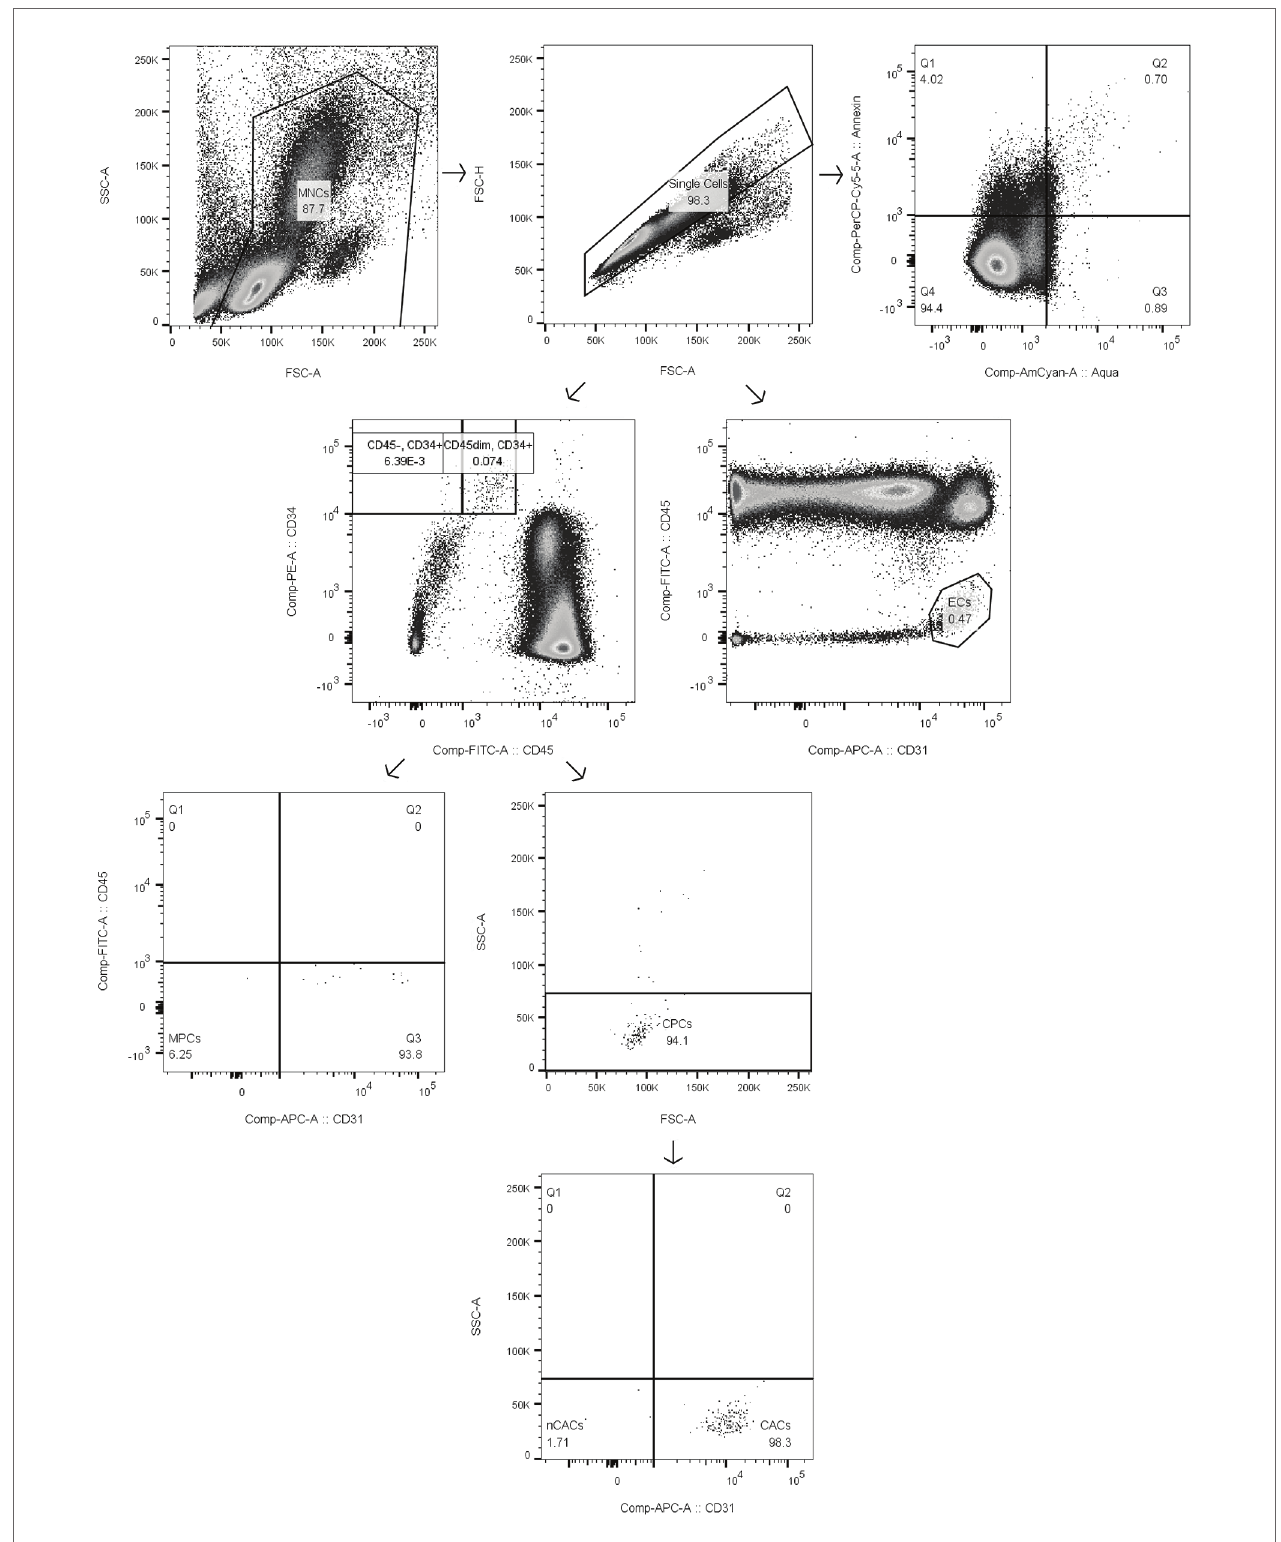
FIGURE 1 | Gating strategy of mononuclear cells (MNCs), circulating angiogenic precursor cells (CACs), circulating non-angiogenic precursor cells (nCACs), mesenchymal precursor cells (MPCs), endothelial cells (ECs), and apoptotic MNCs as representative example of gating of apoptotic subsets. Numbers in boxes represent % of parent